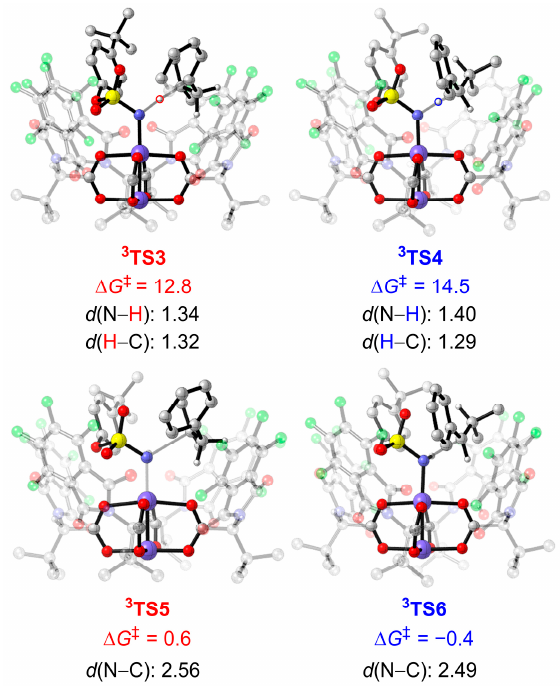
Figure 8. Optimized geometries and energies of 3 TS3 , 3 TS4 , 3 TS5 and 3 TS6 . The distances are in Å, and energies are shown in kcal mol − 1 . Free energy obtained at the ONIOM(M06/def2 − TZVP:UFF//BPW91/6 − 31G* − LANL2DZ:UFF) level. The H atoms of t Bu groups and aryl groups are omitted for clarity.